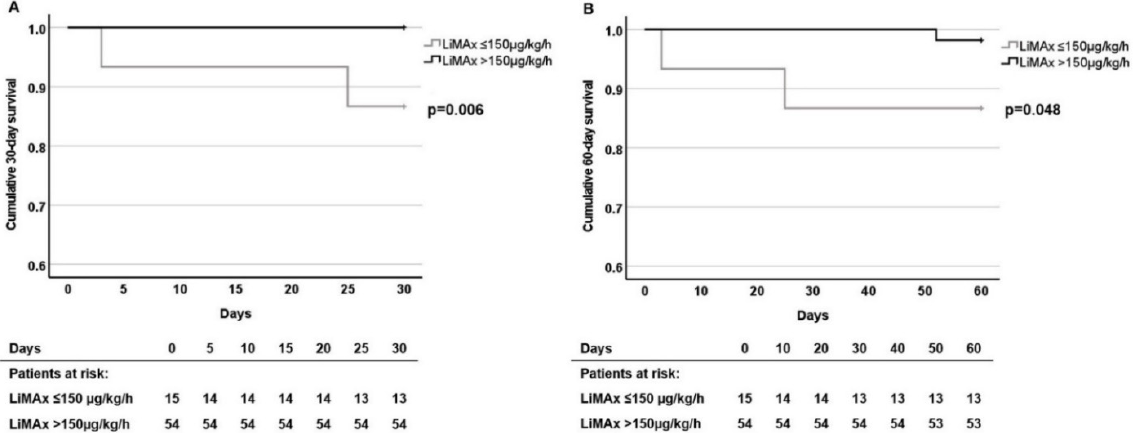
Figure 3. Survival rates in the total cohort according to the LiMAx ≤ 150 µ g/kg/h and LiMAx > 150 µ g/kg/h groups: ( A ) 30 days and ( B ) 60 days after transarterial treatment. Survival analyses were performed with Kaplan-Meier estimator.